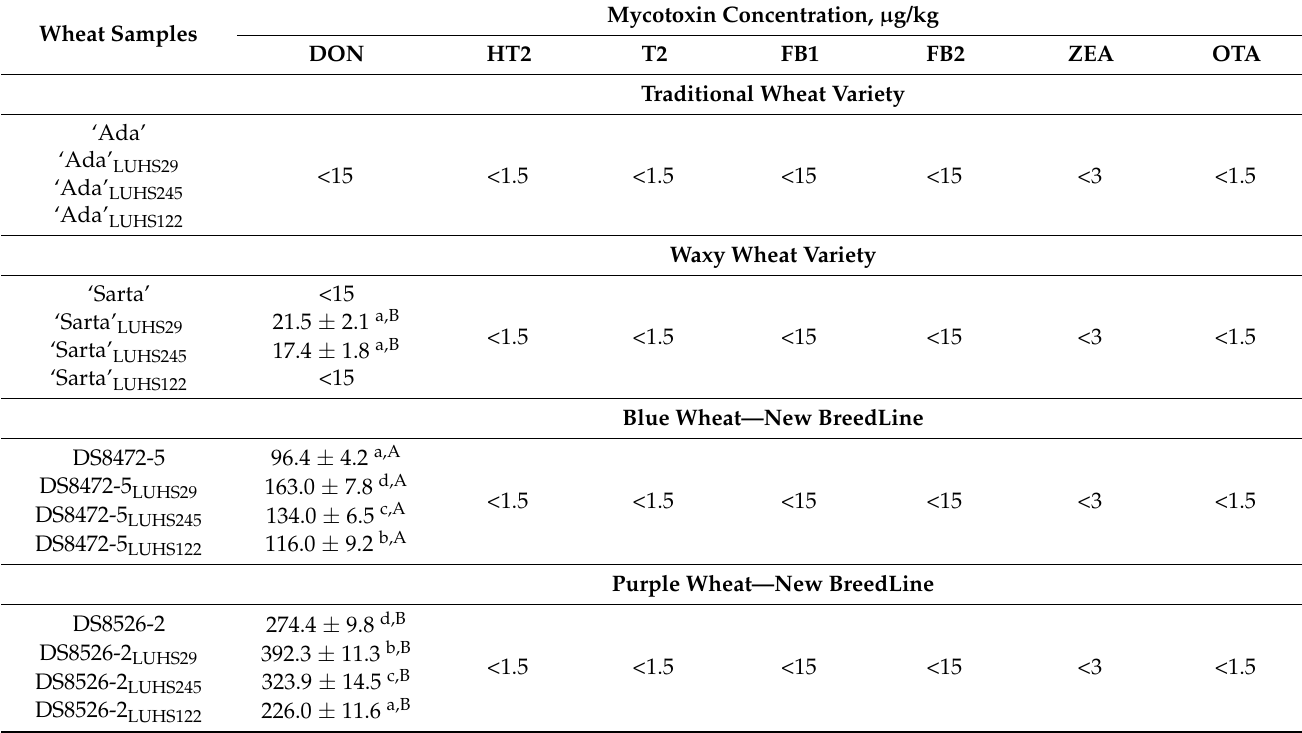
Table 6. Mycotoxin concentration in wheat wholemeal samples. Wheat Samples